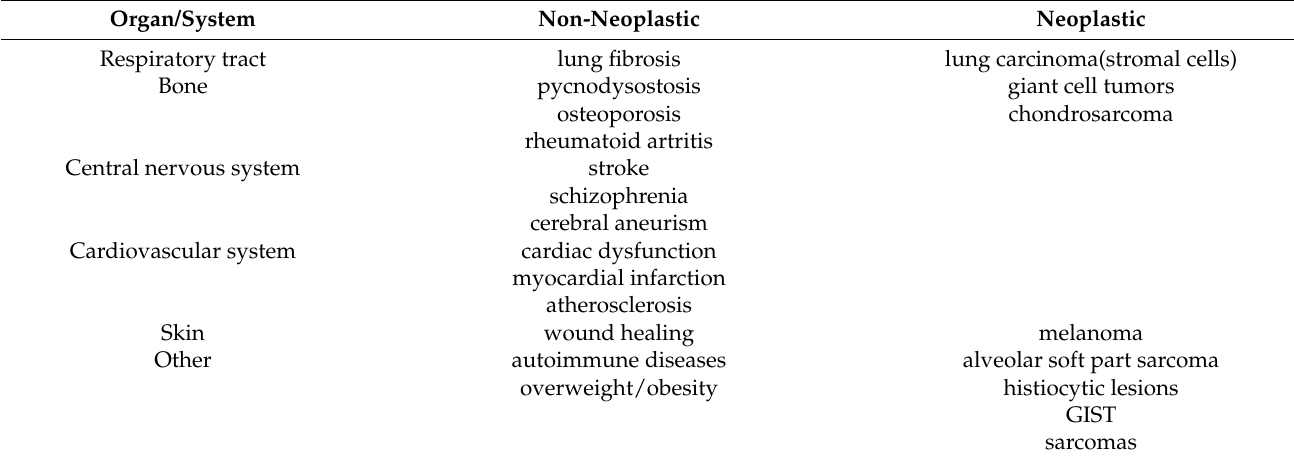
Table 1. Cathepsin K in human diseases (except